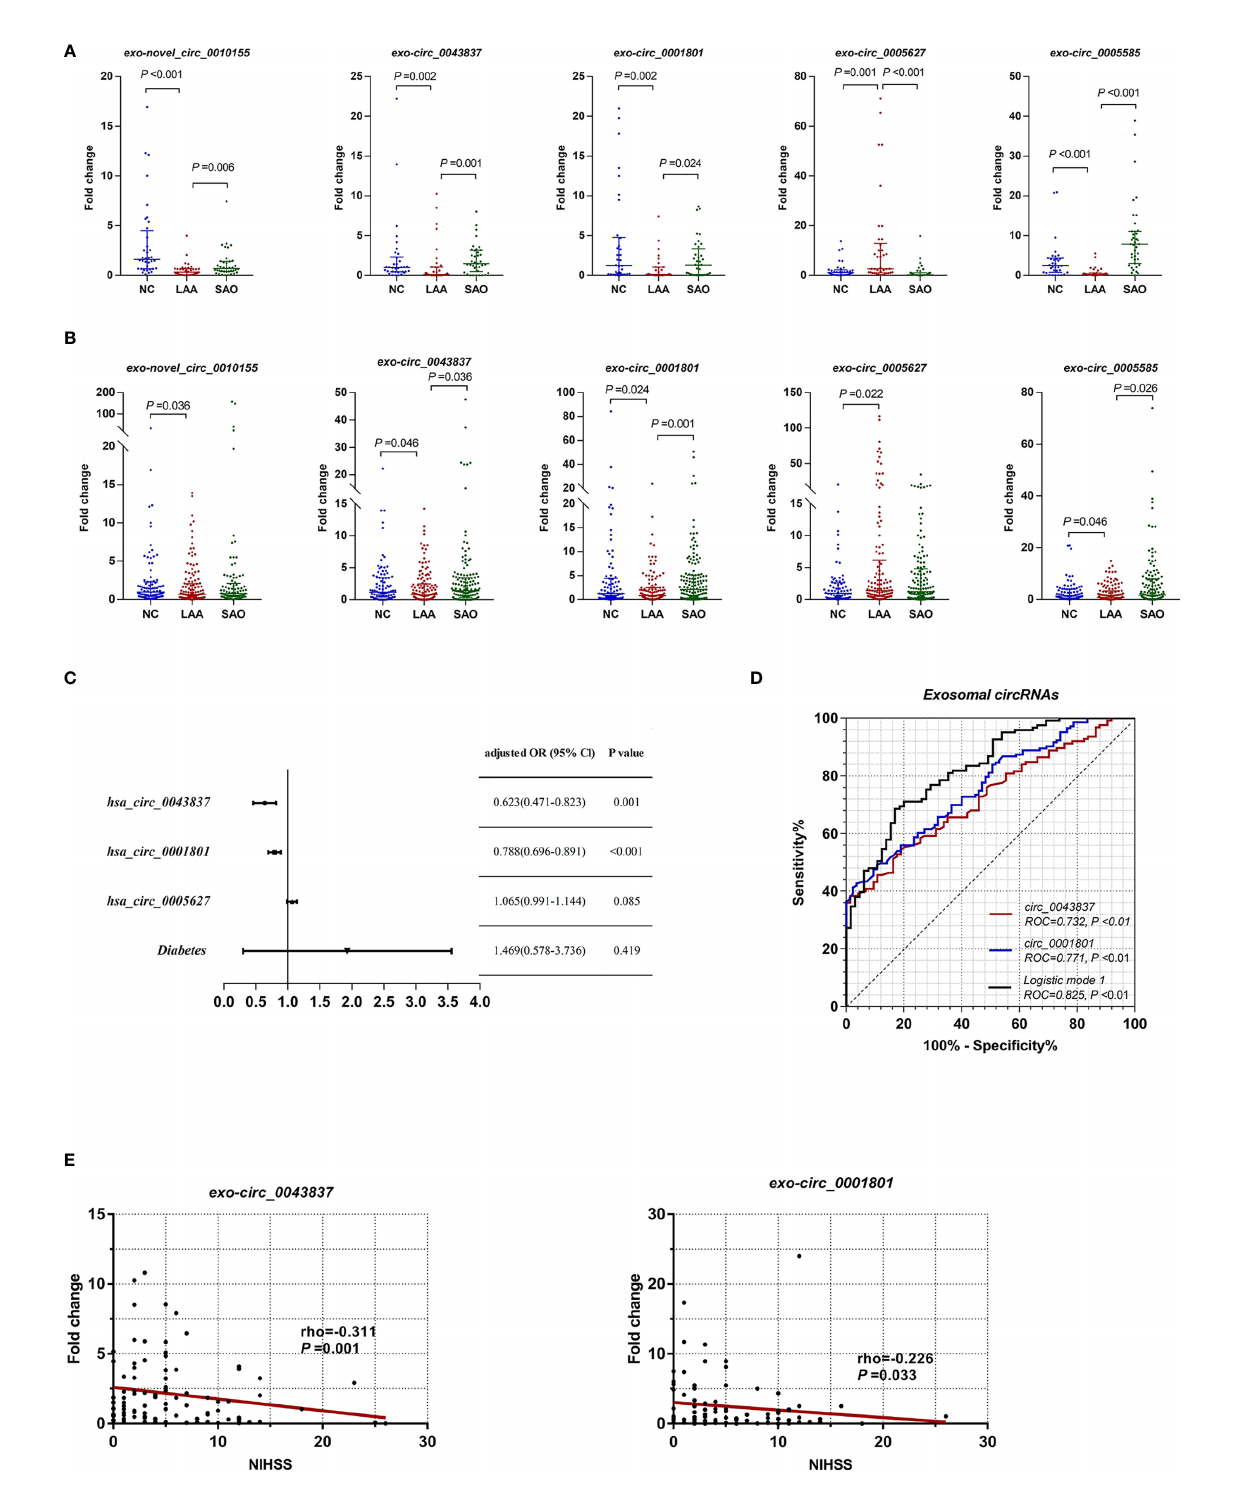
FIGURE 2 | Expression of exosomal circRNAs as novel biomarkers for LAA stroke. (A) Validation of exosomal novel_circ_0010155, circ_0043837, circ_0001801, circ_0005627, and circ_0005585 in NC, LAA, and SAO groups. (B) Replication of exosomal novel_circ_0010155, circ_0043837, circ_0001801, circ_0005627, and circ_0005585 in the NC, LAA, and SAO groups . (C) Multivariate logistic regression analysis for exo-circRNAs. (D) ROC curves of the exosomal circRNAs, logistic mode 1: Two-exo-circRNA of hsa_circ_0043837 and hsa_circ_0001801. (E) Comparison between exosome derived circRNA and NIHSS